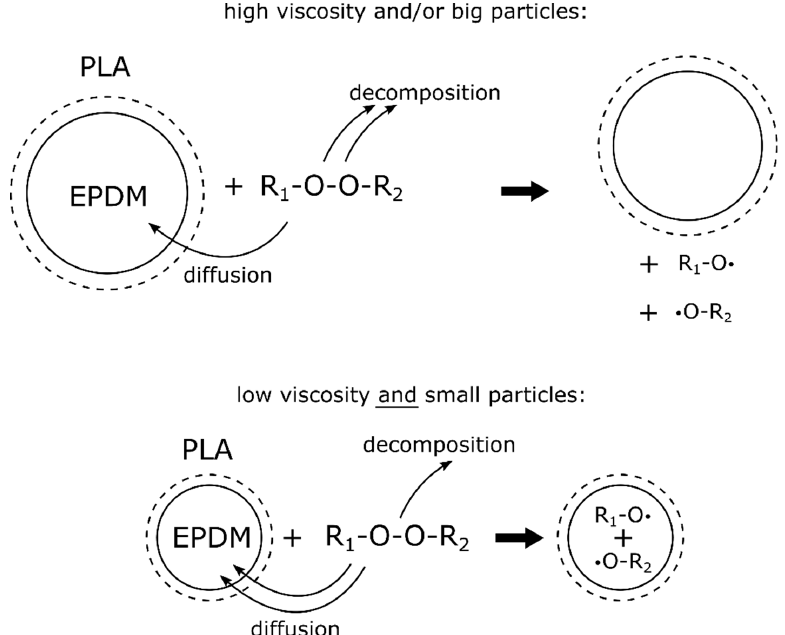
Figure 9. Proposed mechanism for peroxide diffusion and decomposition in the PLA–EPDM blends